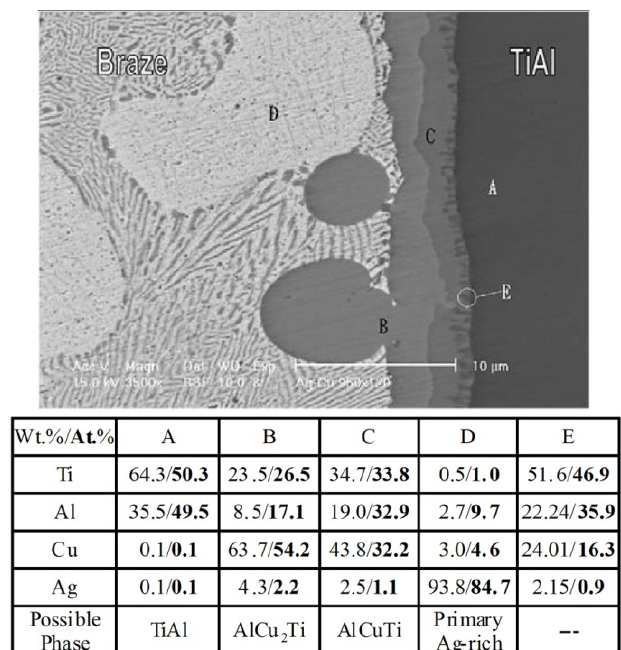
Figure 3. SEM BEI and EPMA chemical analysis results of the TiAl/BAg-8/TiAl specimens brazed at 950 °C for 120 s. (Reprinted with permission from [15]. Copyright 2003,